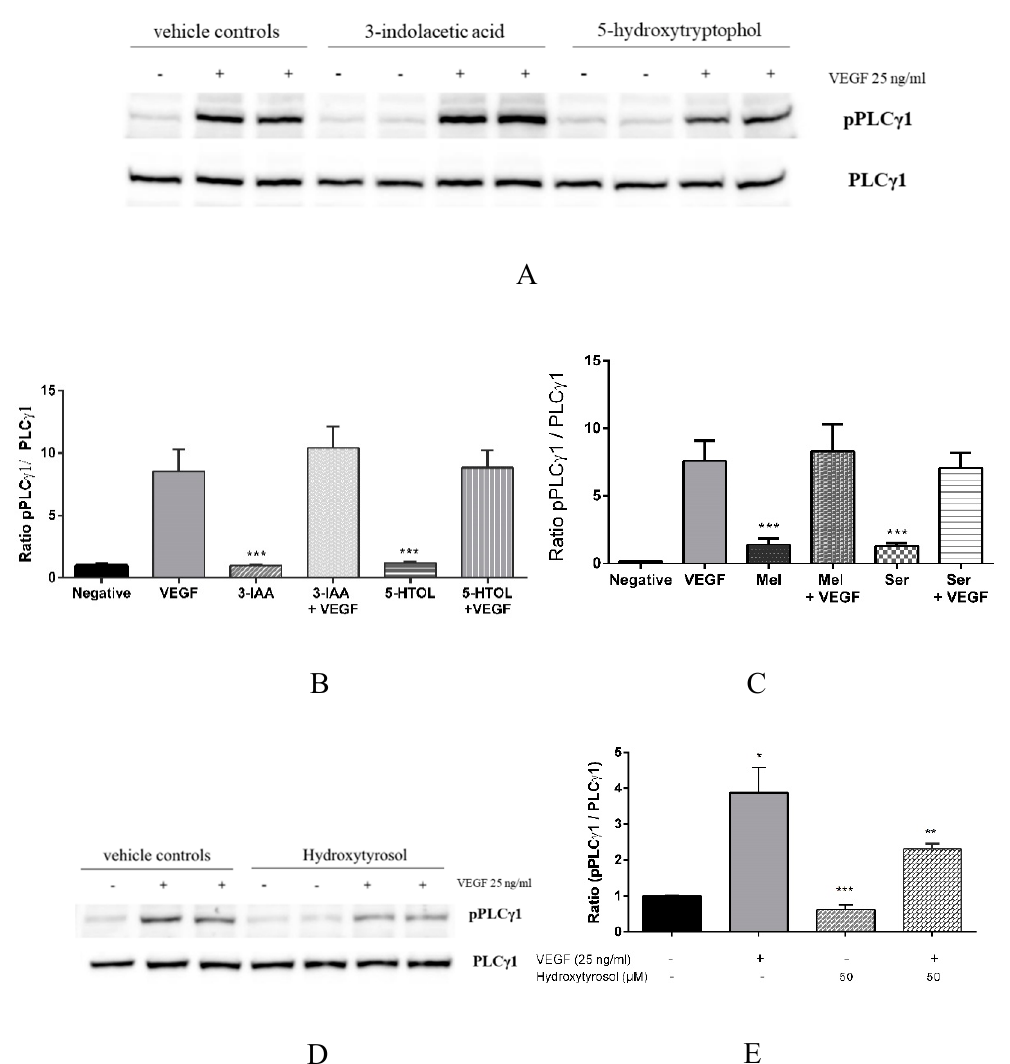
Figure 3. Hydroxytyrosol inhibits PLC γ -1 phosphorylation. HUVECs were treated with ( A – C ) 3-indolacetic acid (1 mM), 5-hydroxytryptophol (1 mM), melatonin (1 mM) and serotonin (1 mM), and ( D and E ) hydroxytyrosol (50 µ M) for 4 h and then incubated with VEGF (25 ng / mL) for 10 min. Western blot membranes were incubated with anti-PLC γ -1 and anti-p-PLC γ -1 antibodies. Data representations of the p-PLC γ -1 / PLC γ -1 ratio are expressed as the mean ± SD ( n = 4). * p < 0.05; ** p < 0.01; *** p < 0.001 versus VEGF alone. IAA: 3-indolacetic acid; 5-HTOL: 5-hydroxytryptophol; Mel: melatonin; Ser: serotonin.